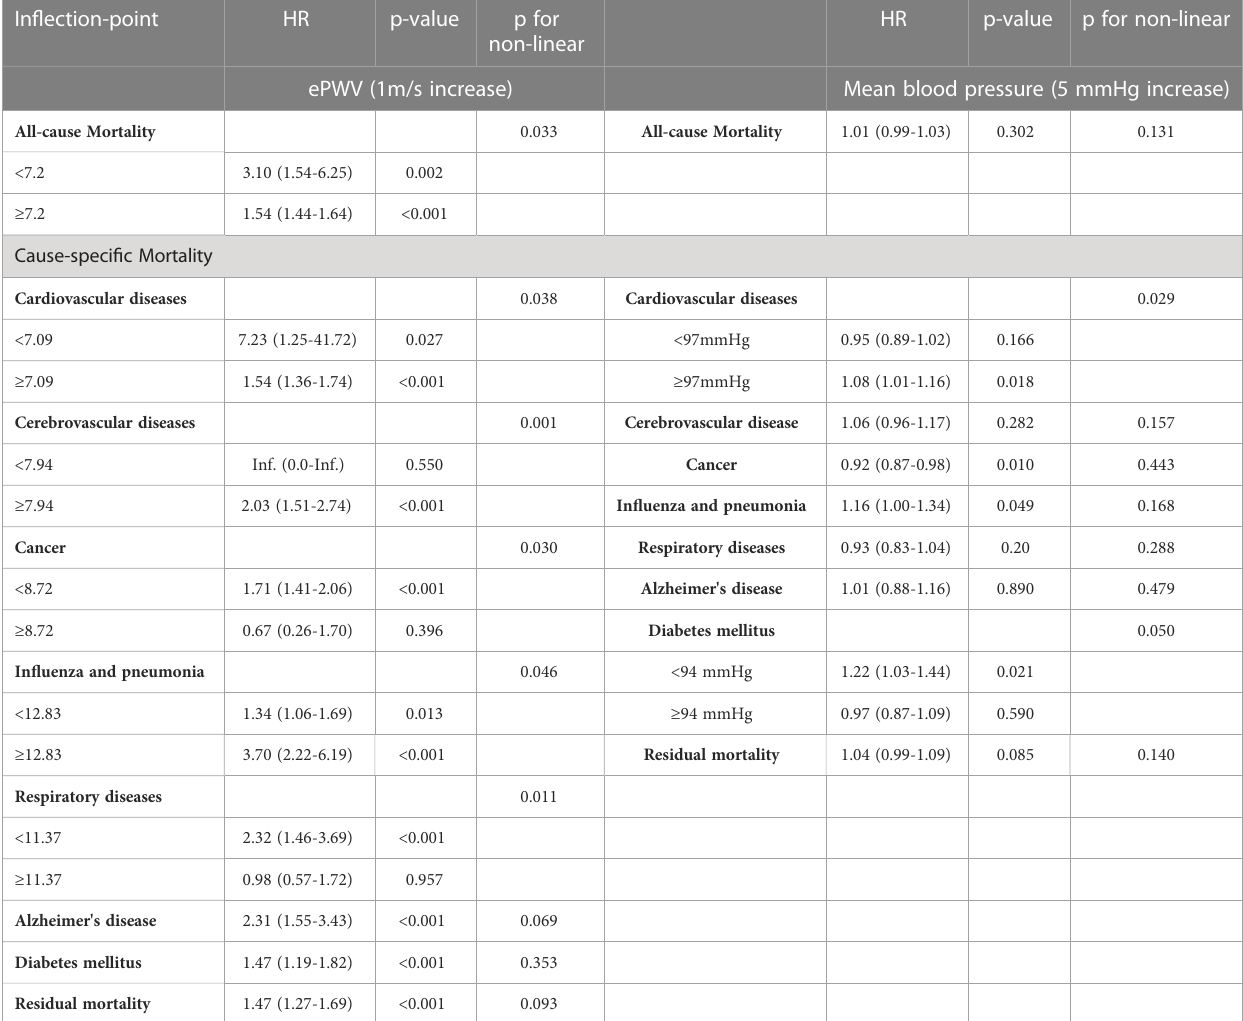
TABLE 3 Threshold-effect analysis on ePWV, MBP and all-cause and cause-speci fi c mortality. In fl ection-point